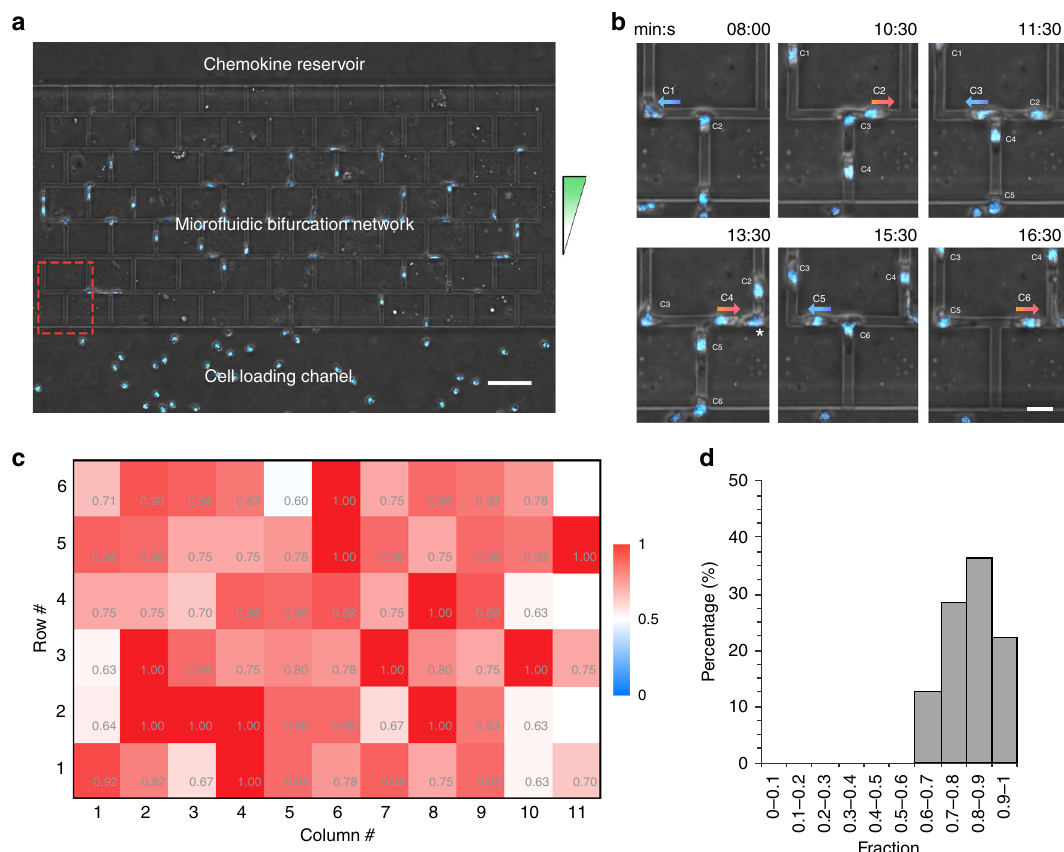
Fig. 8 Migration patterns of an army of neutrophils in a micro fl uidic bifurcation network. a The design of the micro fl uidic bifurcation network. The scale bar is 50 µ m. The green arrow indicates the chemoattractant gradient. The neutrophils were stained with Hoechst and pseudocolored blue. b Time-lapse microscopic images showing the migration patterns of six neutrophils at one of the bifurcations in the network. The location of the bifurcation is indicated with red dashed rectangle in panel ( a ). The scale bar is 10 µ m. c A heatmap showing the fraction of neutrophils moving to alternate branches at all the bifurcations in the network ( N = 3 donors, N = 993). The blue, white and red colors represent a fraction of 0, 0.5, and 1, respectively. d A histogram showing the distribution of the fractions derived from panel